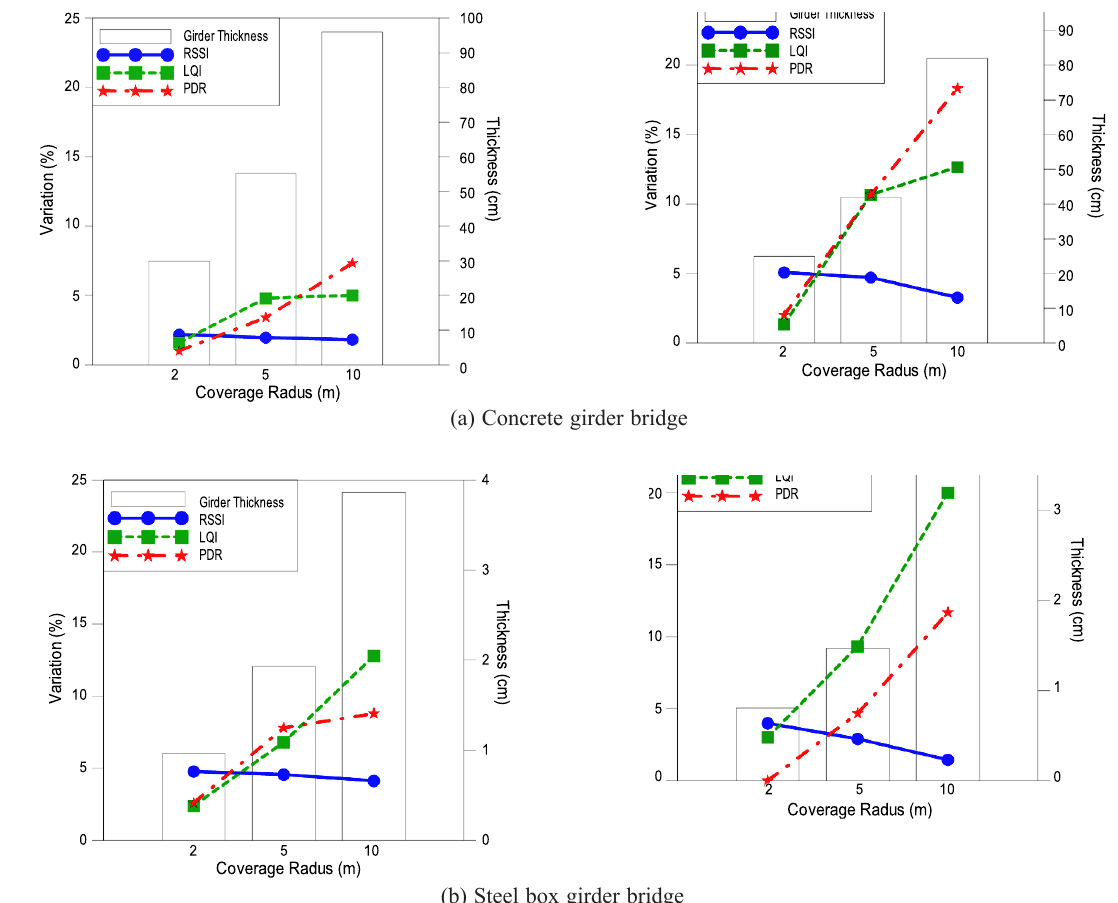
Fig. 9. Selection of random measurement points in each bridge (left: BS at center; and right: BS at